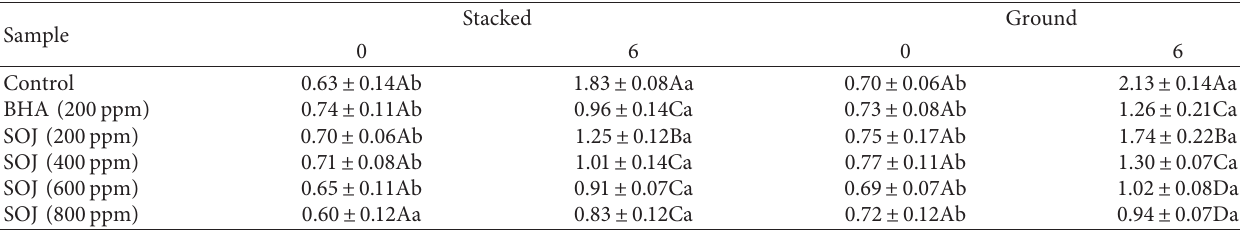
∗ Data represent mean ± standard deviation of three independent repeats. ∗∗ Different capital letters in each column and lowercase ones in each row indicate significant differences ( p < 0 . 05 ) .